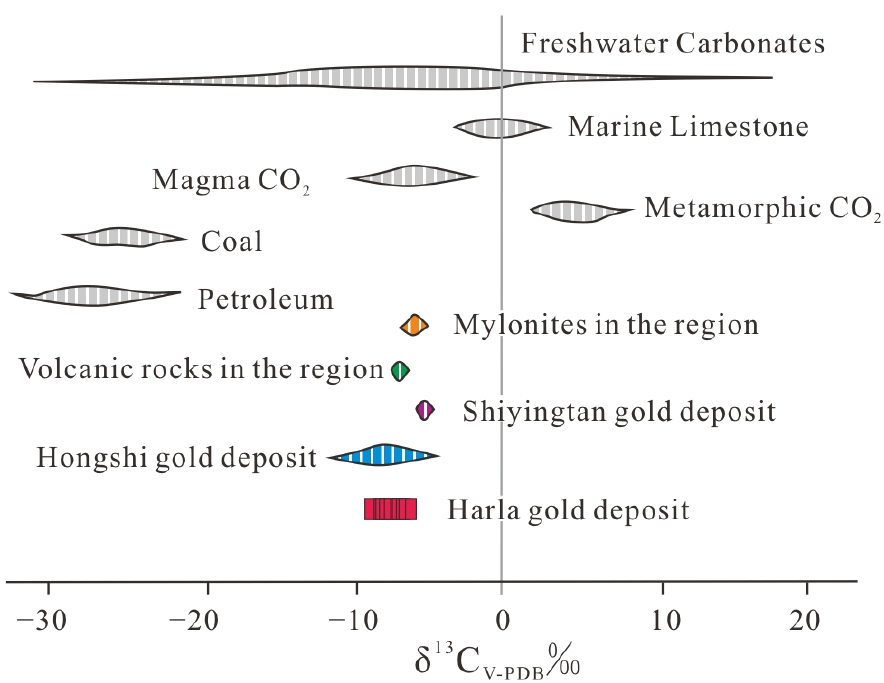
Figure 9. δ 13 C values for FI water from the Harla gold deposit compared with other typical gold deposits. δ 13 C values of important geological reservoirs are from Clark and Fritz [31]. Data for other gold deposits and wall rocks in the region are from Wang et al. [32] and Wang et al.